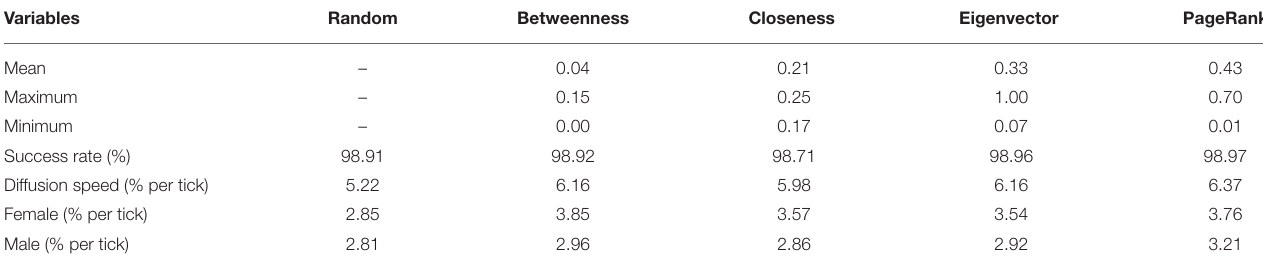
TABLE 3 | Descriptive statistics for the social network